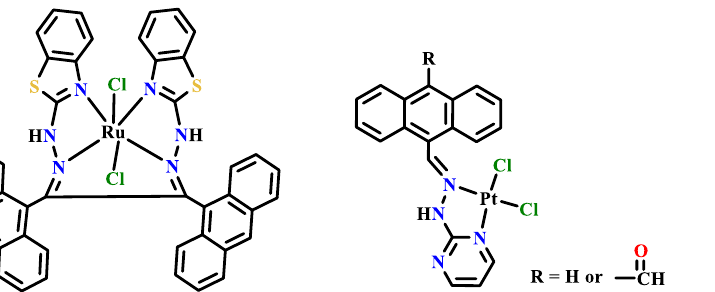
Figure 48. The Ru(II) and Pt(II) complexes of 9-anthrachydrazone with benzothiazole and pyrimidine as side chains.